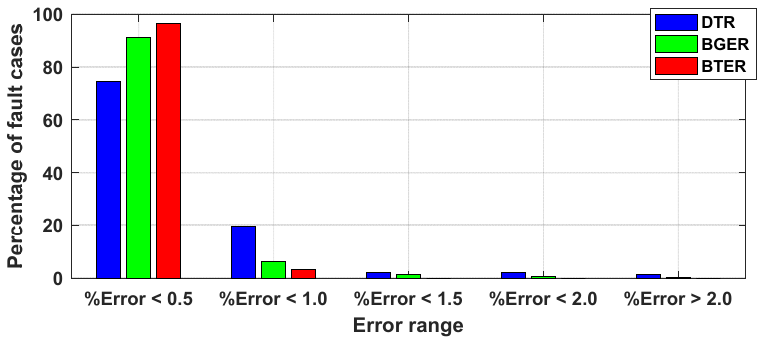
Figure 13. Comparison of various techniques used. Table 8. Comparison with other methods.